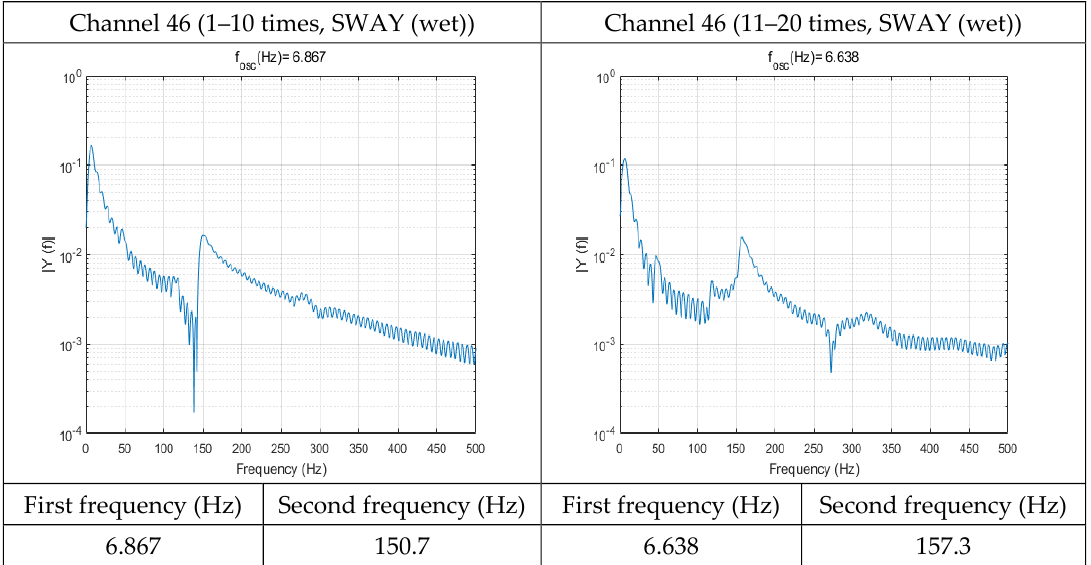
(d) Figure 17. Time Histories of the Pressure Measured at Four Different Channels for ROLL (Wet): ( a ) Channel 46, ( b ) Channel 51, ( c ) Channel 58 and ( d ) Channel 63. For the SWAY, where bubbles were abundantly generated, high-frequency oscillation occurred as shown in Figure 16. Figures 18–21 show the results of a FFT frequency analysis of the data in Figure